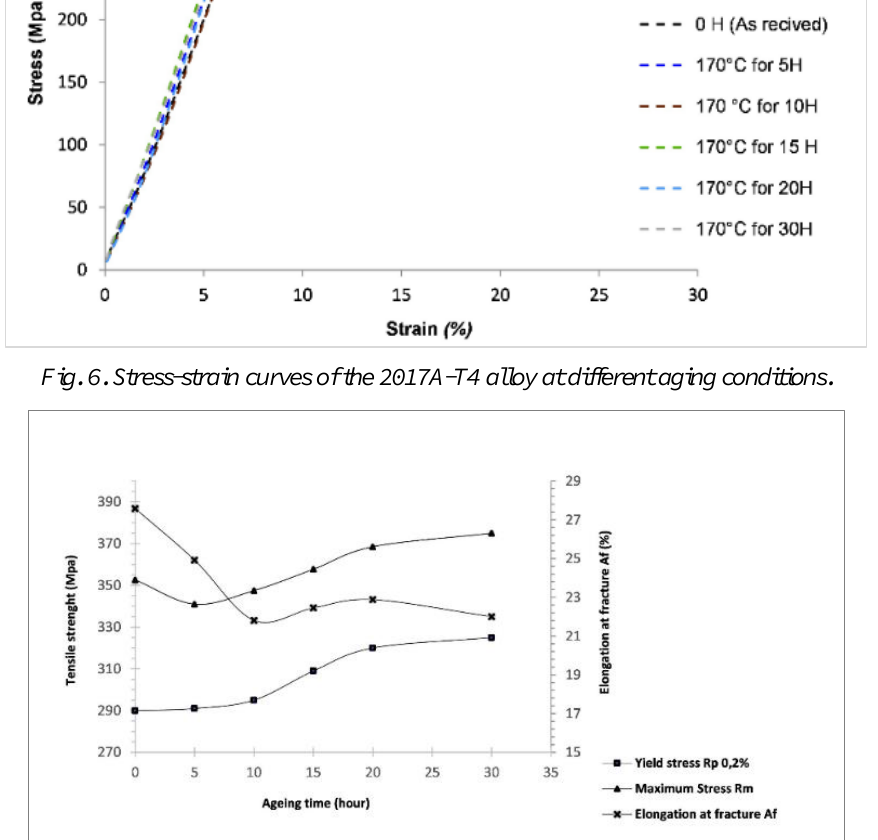
and yield stress 𝒎 is observed, this is due to 𝒇